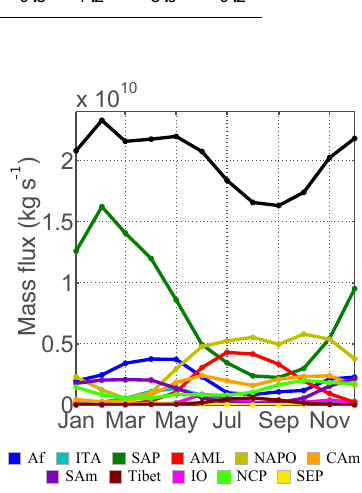
Figure 12. Mean annual cycles of monthly upward mass fluxes through the 380K isentropic surface within the 40 ◦ S–40 ◦ N band attributed to each source region. Fluxes are based on backward tra- jectories during 2005–2008. The black curve shows M defined relative to back trajectory launch at 380K, rather than the convective